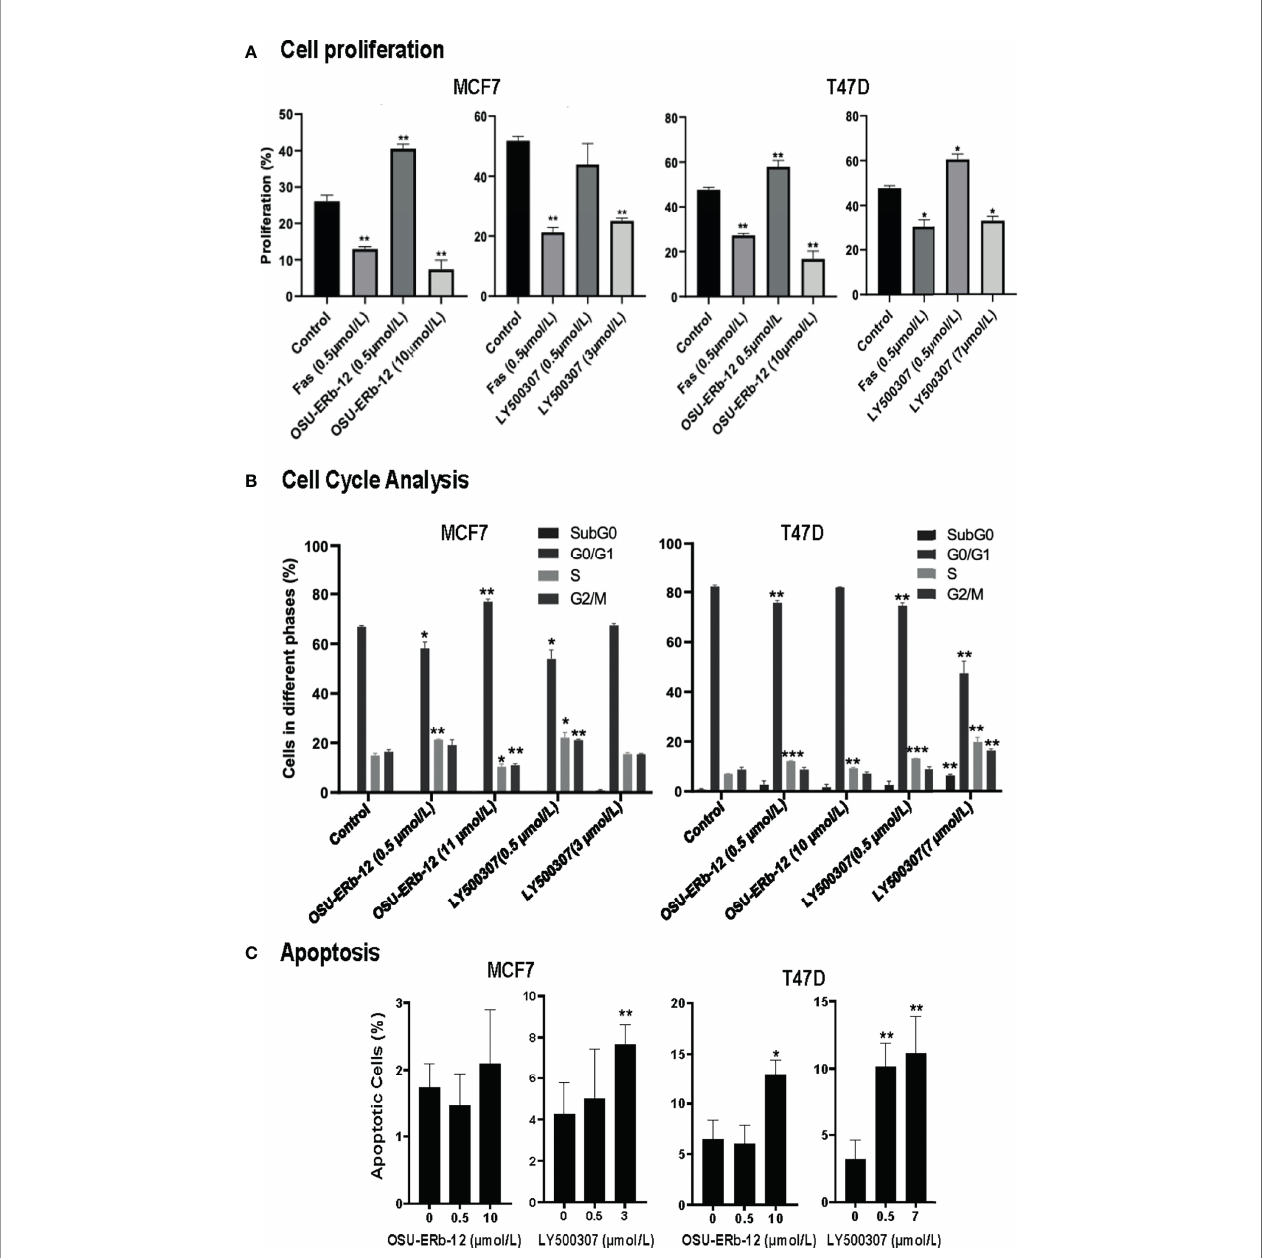
FIGURE 4 | Cell proliferation, cell cycle, and apoptosis are affected upon treatment of ER a + breast cancer cells with ER b -speci fi c agonists, OSU-ERb-12, and LY500307. MCF7 and T47D cells (0.5 × 10 6 ) were seeded on 100-mm dishes in phenol red free DMEM containing charcoal-stripped FBS and treated with the drugs as indicated. (A) A representative diagram of the cell proliferation pro fi le in drug-treated cells. Cells were treated with DMSO (control), FAS (fulvestrant; negative control), OSU-ERb-12, or LY500307 for 72 h, harvested, and stained following protocol for the Click-iT EdU Alexa Fluor 647 Kit (Invitrogen C10424). Cell proliferation was analyzed via fl ow cytometry on a BD FACSCalibur Flow Cytometer. Each assay was performed in triplicate and repeated twice. Data were plotted as mean ± SD (*p < 0.05, **p <0.01). (B) A representative diagram depicting the cell-cycle pro fi le in drug-treated cells. Cells treated with DMSO (control), OSU-ERb-12, or LY500307 for 72 h at the indicated concentrations were harvested on ice, fi xed, washed, and incubated with propidium iodide and RNase A followed by cell-cycle analysis on a fl ow cytometer. Each assay was performed in triplicate and repeated twice. Data were plotted as mean ± SD (*p < 0.05, **p < 0.01, ***p < 0.001). (C) A representative diagram depicting the apoptosis pro fi le in drug-treated cells. Cells treated with DMSO (control), OSU-ERb-12, or LY500307 for 48 h at the indicated concentrations were harvested on ice, washed, and processed according to the manufacturer ’ s protocol (TUNEL Assay Kit-BrdU-Red; Abcam) followed by analysis on a BD FACSCalibur Flow Cytometer. Each experiment was repeated twice. Data presented are mean ± SD (*p < 0.05, **p < 0.01). In all assays, results shown are pooled averages across biological